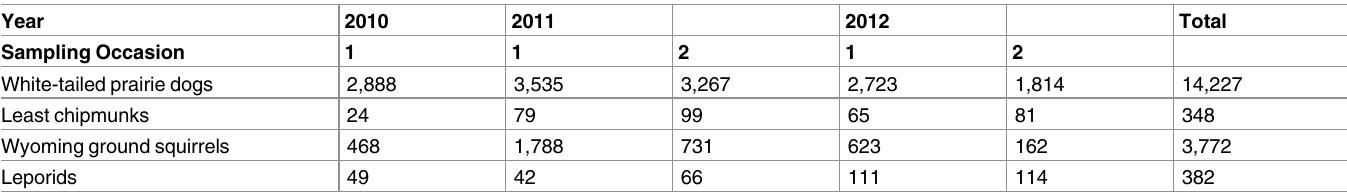
Table 2. Number of individuals of the most abundant small mammal species groups detected during each sampling occasion and summed over all sampling occasions from line transect surveysin Wyoming,